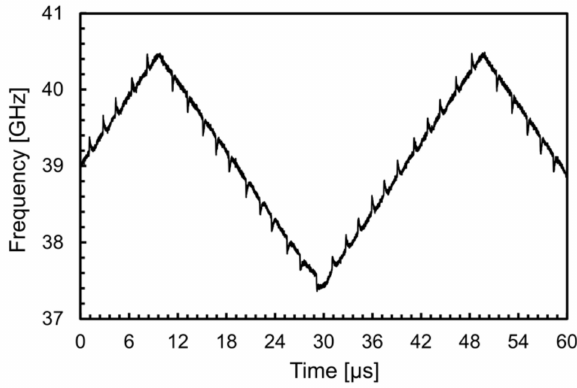
Figure 10. Measured dynamic frequency locking with a triangular reference frequency.